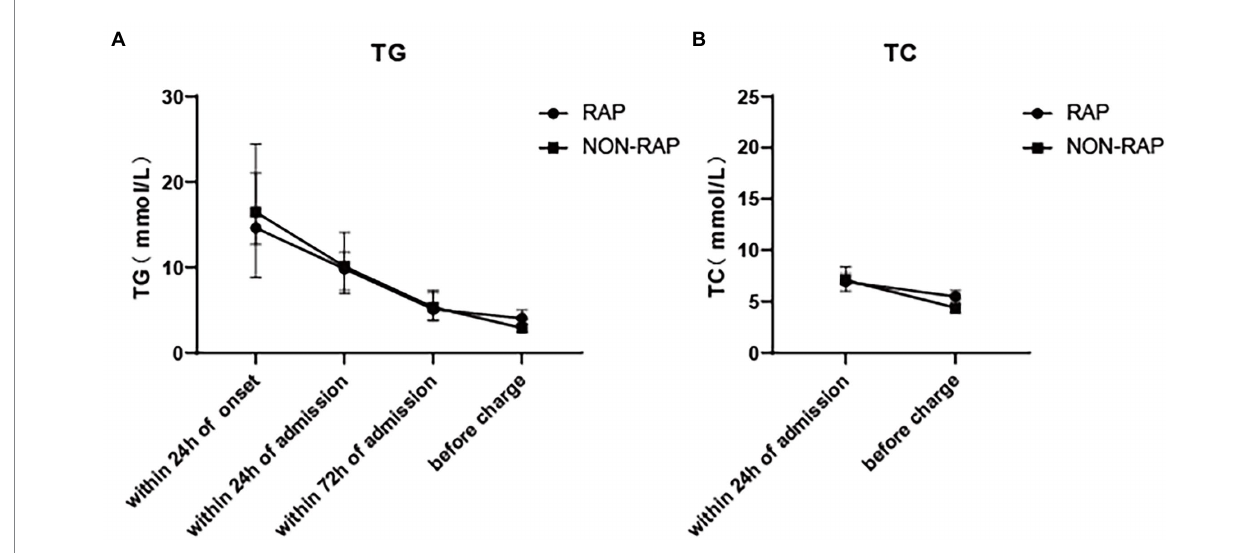
FIGURE 2 Dynamic change of serum lipid levels of patients with HTGP during index hospitalization, (A) the serum TG levels, (B) the serum TC